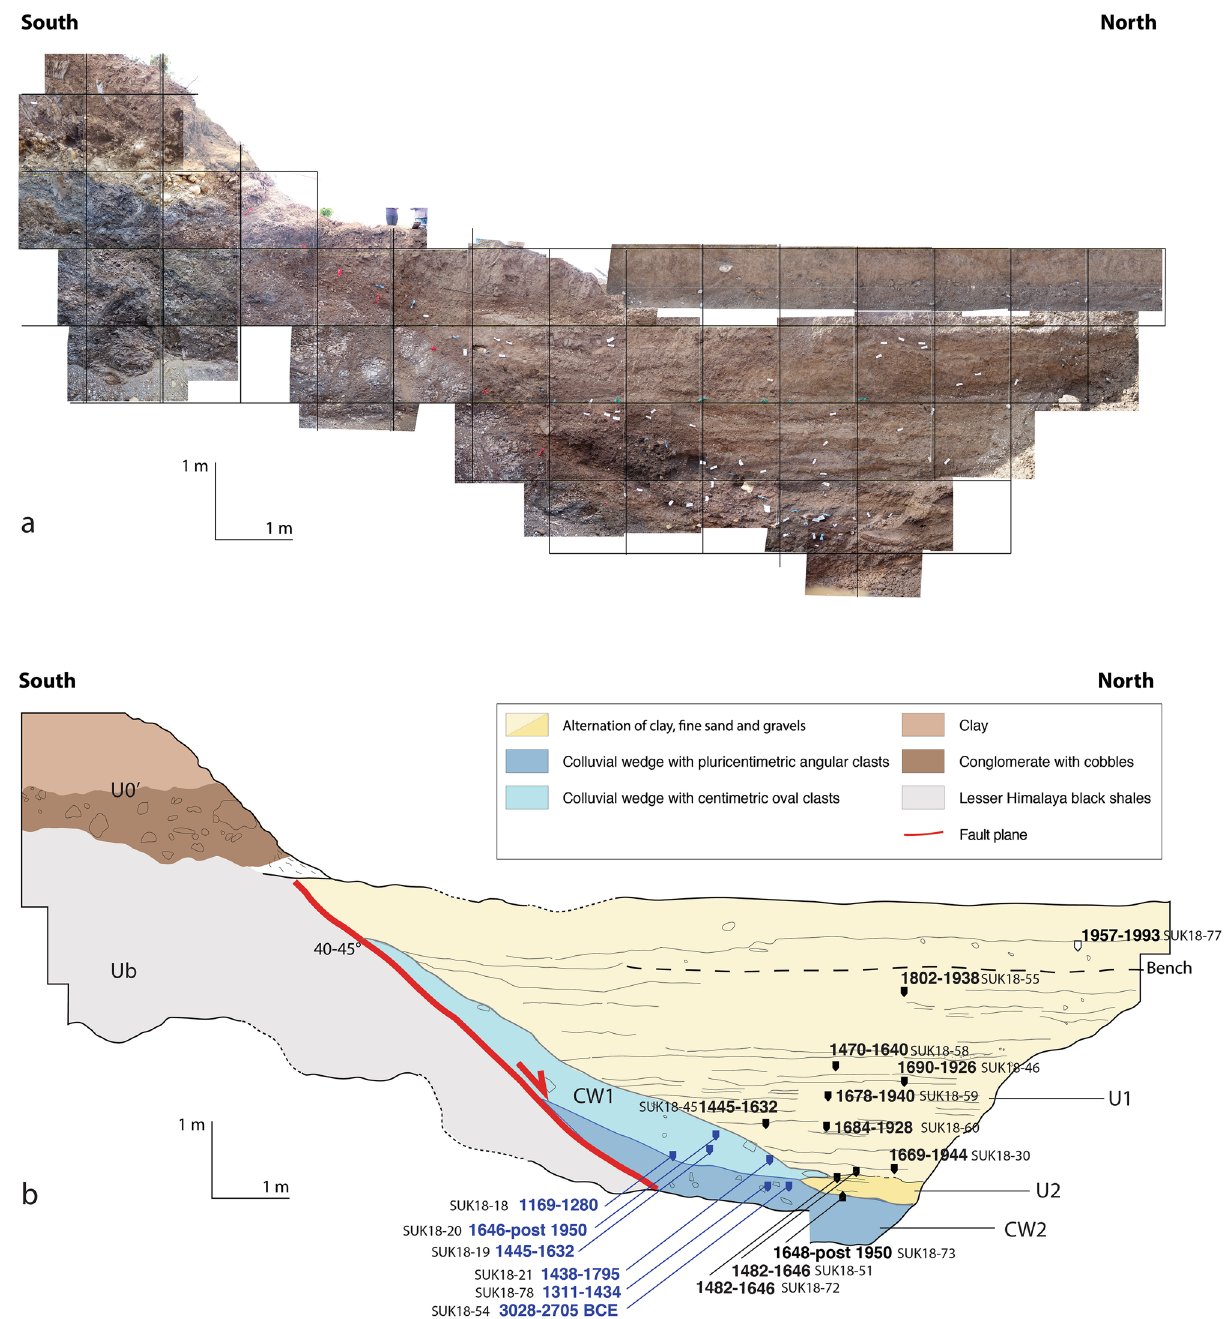
Figure 6. ( a ) Ortho-mosaic of the Sukhetal trench eastern wall. The orthomosaic and log of the trench eastern wall are mirror images of the real observations (flipped N–S) to simplify the comparison to classic Himalayan sections. ( b ) Interpreted log of the trenchwith the location of 18 radiocarbon ages from detrital charcoals (in the colluvial wedges and stratigraphic units in blue and black, respectively). The minimum and maximum at 2 sigma of the individually calibrated detrital charcoal calendar ages are reported. The ages associated to the charcoals found in the colluvial wedges are reported in blue. CW1, colluvial wedge brown-reddish unit of gravels and pebbles, in light blue, CW2, colluvial wedge incorporating pluricentimetric clasts, in dark blue. Units U1 in light yellow, U2 in dark yellow, For sample analysis see Table S1. Figure generated with Adobe illustrator CS6 (http:// www. adobe. com/ fr/ produ cts/ illus trator.